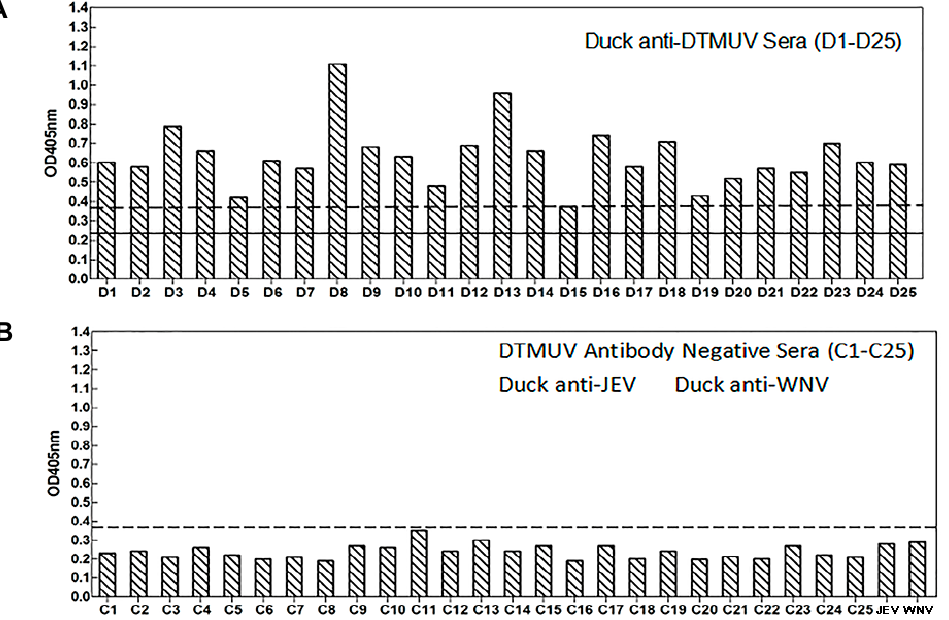
Figure 9. ELISA reactivity of the DTMUV synthetic peptide against serum samples from 25 DTMUV-infected duck ( A ) versus sera from 25 healthy ducks ( B ). The cutoff value (dashed lines) was calculated as 0.375. Solid line, mean OD405.